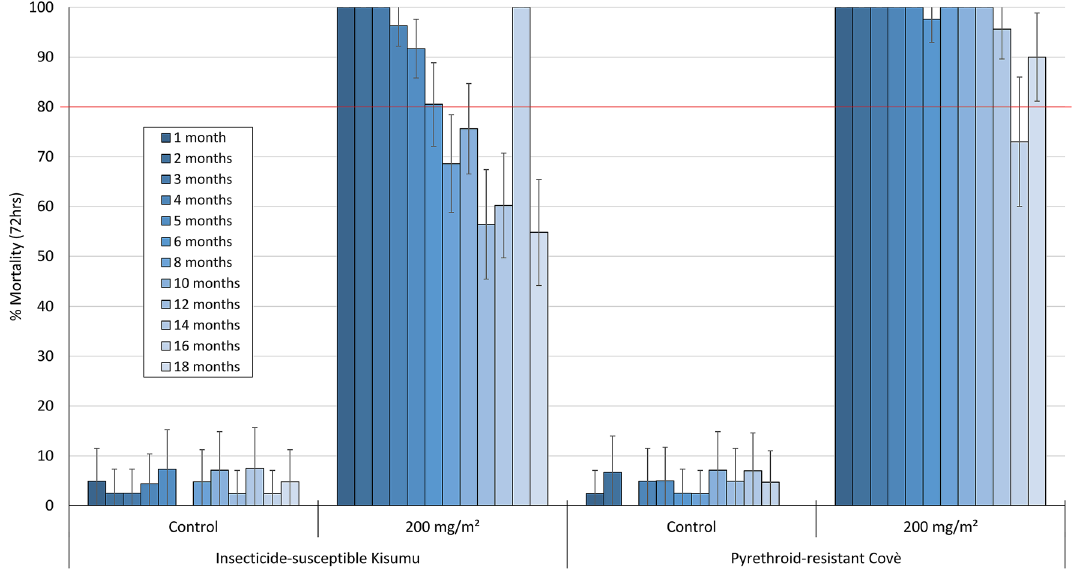
Figure 3. Monthly cone bioassays mortality of insecticide-susceptible An. gambiae ss Kisumu and pyrethroid- resistant An. gambiae sl Covè strain mosquitoes on broflanilide WP-treated cement block substrates in the